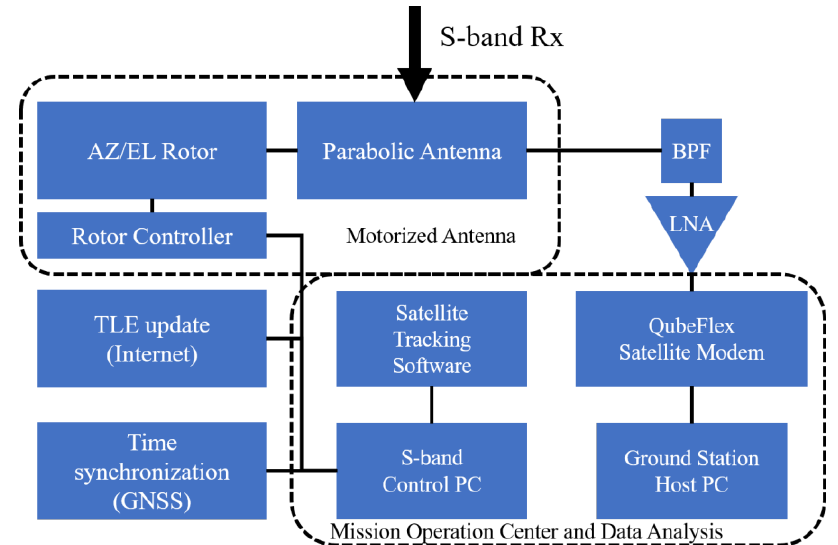
Figure 6. The basic architecture of the NCU S-band ground station.